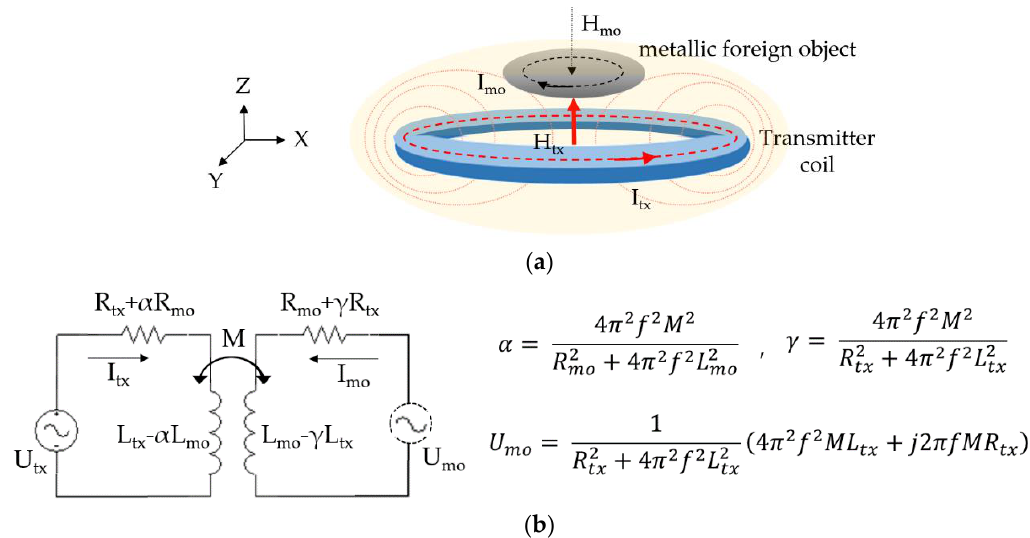
Figure 2. ( a ) The current and magnetic field generation, and ( b ) the equivalent circuit when a metallic foreign object (MO) is placed on the top of the coil.